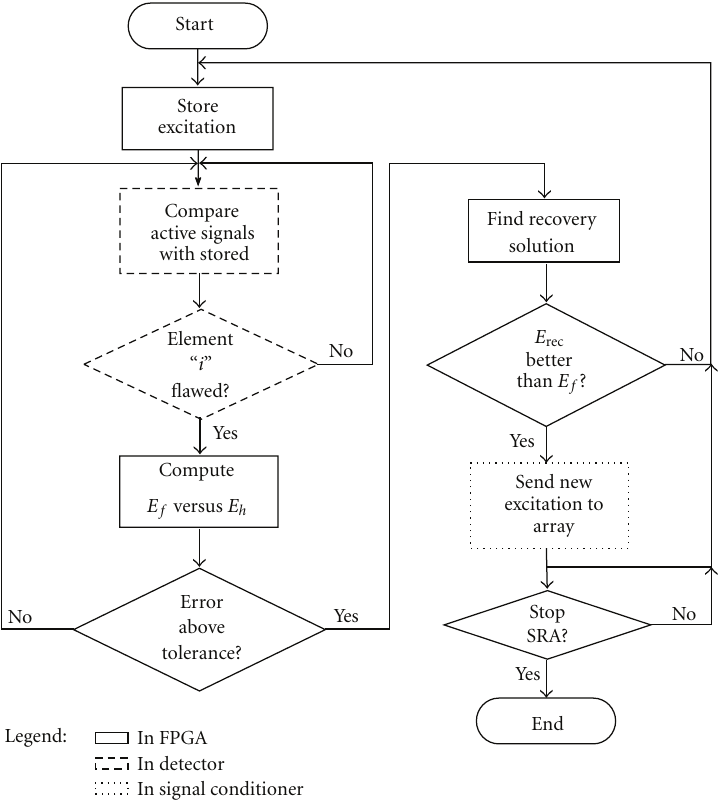
Figure 4: The flowchart of the principal steps in the SRA